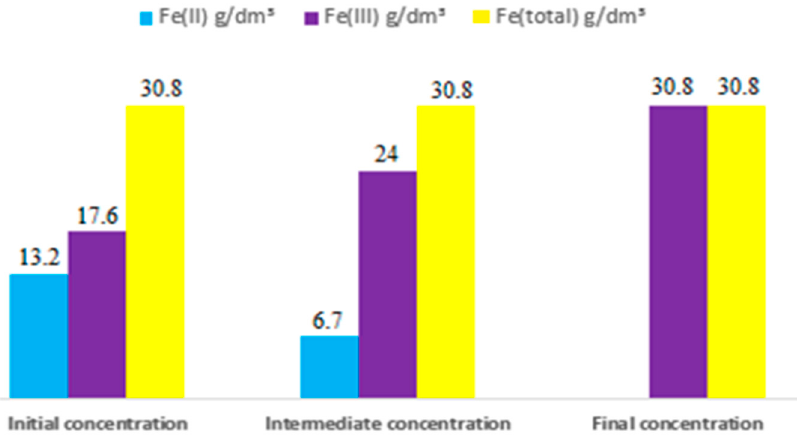
Figure 14. The concentration of iron in the solution after oxidation in the electrolyzer.